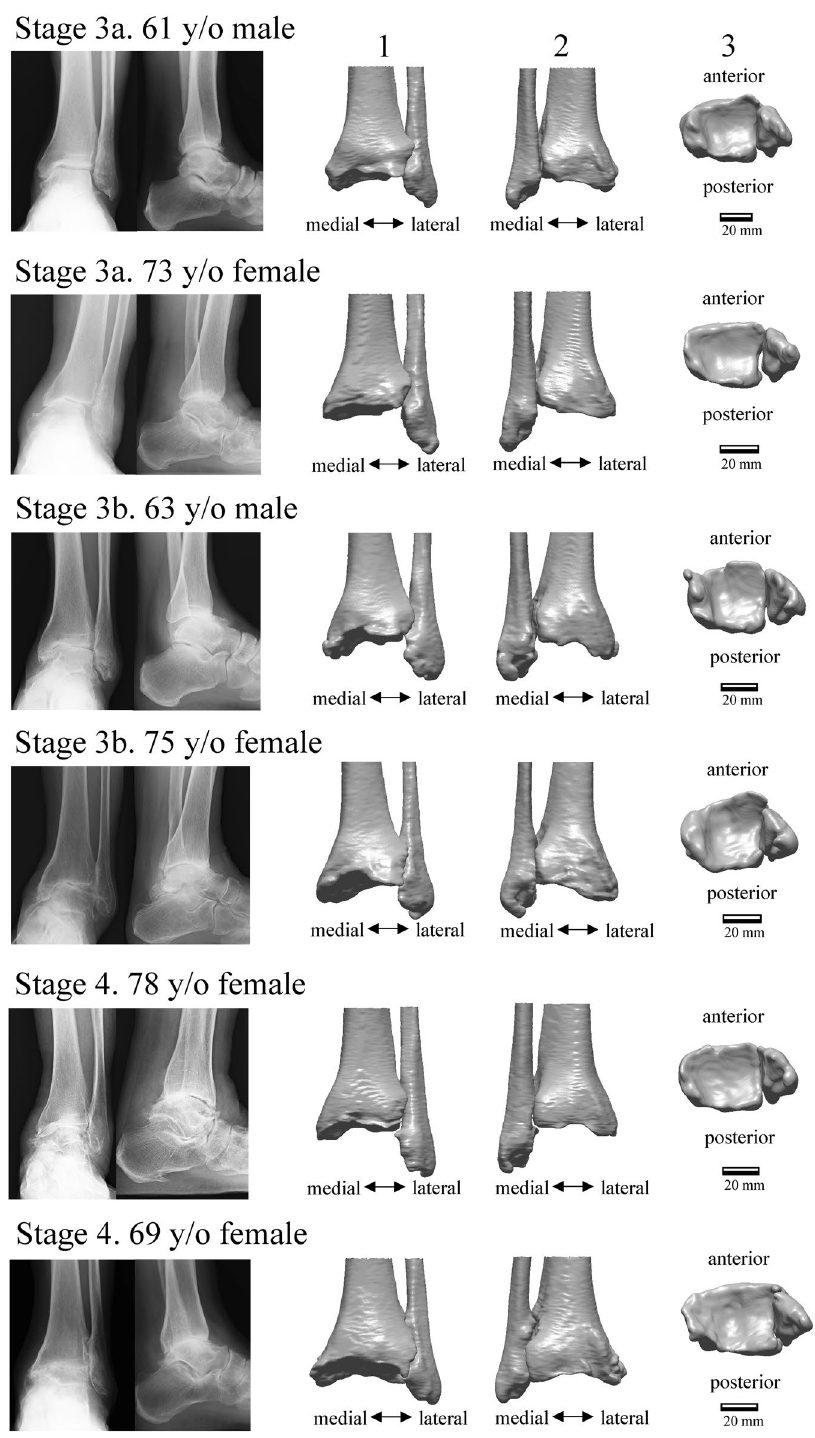
Figure 2. Plain radiographs and bone surface models reconstructed based on CT data of six representative cases, two for each stage, in the osteoarthritis (OA) group. 1. Anterior view. 2. Posterior view. 3. Inferior view. y/o = years